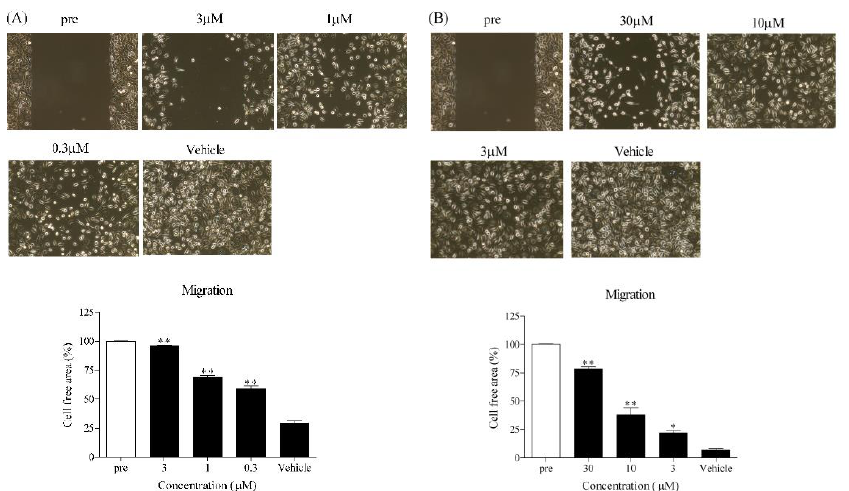
Figure 6. Effect of Amb544925 and C2 ceramide on HSC-3 cell migration. Cell migration assays were performed using culture-inserts. After cells were incubated with various concentrations of Amb544925 ( A ) and C2 ceramide ( B ) for 24 h, images of cell-free areas were acquired by digital microscopy ( n = 4). Cell-free area (%) is expressed as percentage reduction relative to the cell-free area before drug administration (pre). * p < 0.05 and ** p < 0.01 compared to the vehicle